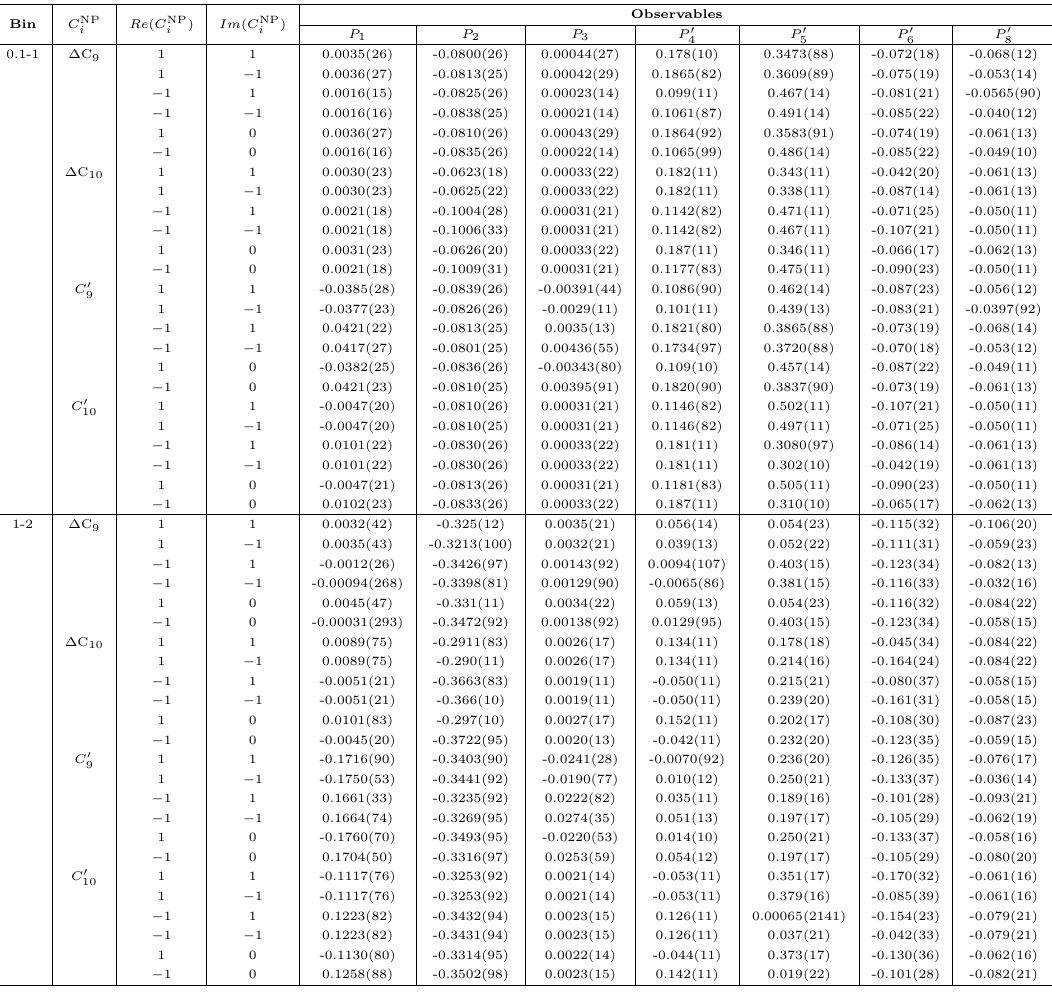
and C 0 for the q 2 bins 0 . 1 − 1 and 1 − 2 GeV 2 for a 9 , 10 9 , 10